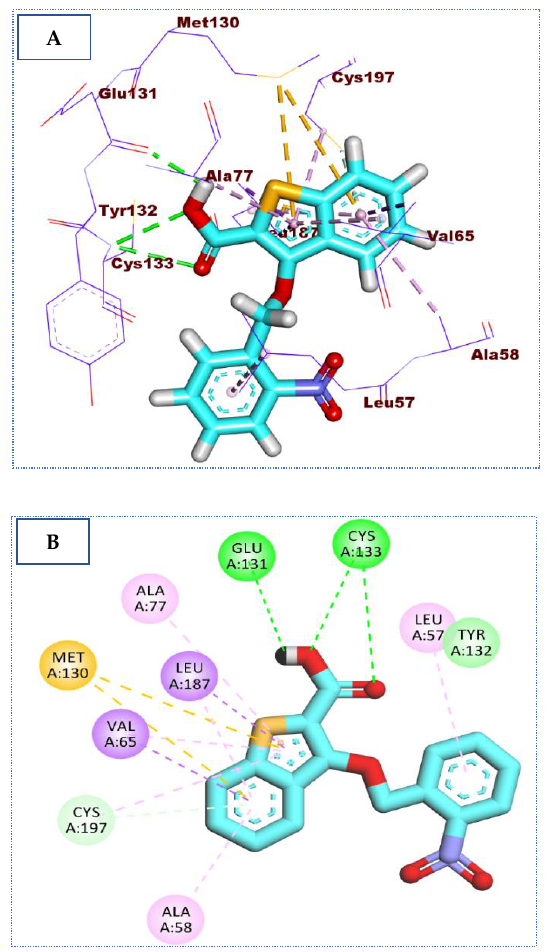
Figure 7. ( A ) The 3D and ( B ) 2D binding of 31 in the active site of BMP-2-inducible kinase (hydrogen bonds = green dashed lines, electrostatic interactions = orange dashed lines, pi-pi interactions = purple dashed lines, and pi-alkyl interactions = light pink dashed lines). Molecular docking results of compound 35 revealed an affinity value of − 24.25 Kcal/mol. The results showed formation of five hydrogen-bonding interactions, ten hy- drophobic interactions, in addition to one electrostatic interaction, as observed in Figure 8.